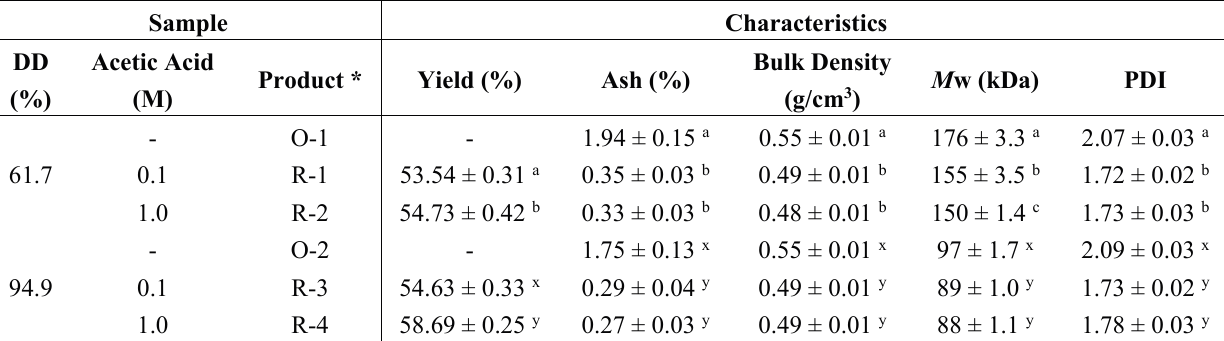
Table 1. Effects of the characters of chitosans used and regeneration conditions on the yield and physicochemical characteristics of regenerated